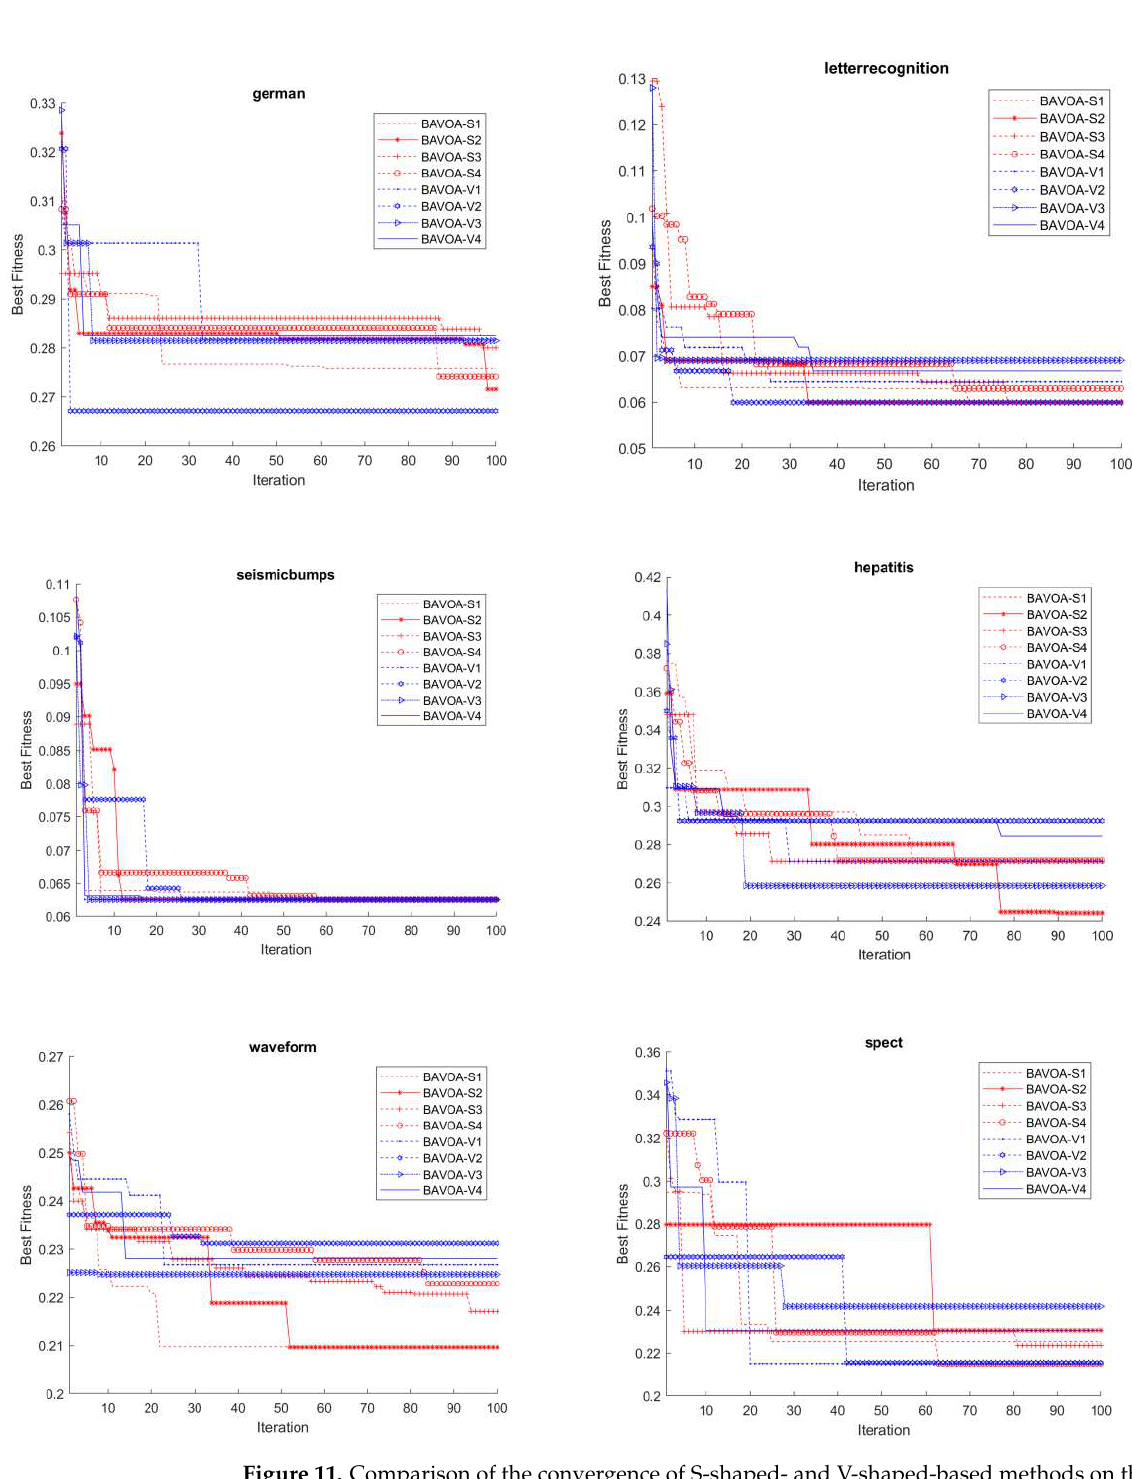
Figure 11. Comparison of the convergence of S-shaped- and V-shaped-based methods on the second 6 data sets .